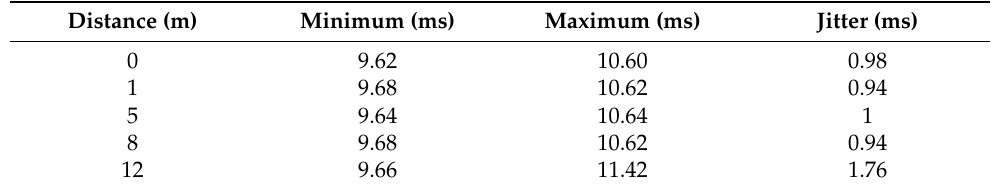
Table 2. Maximum and minimum latency values and jitter for the XBee messages issued by the Wireless Controller.